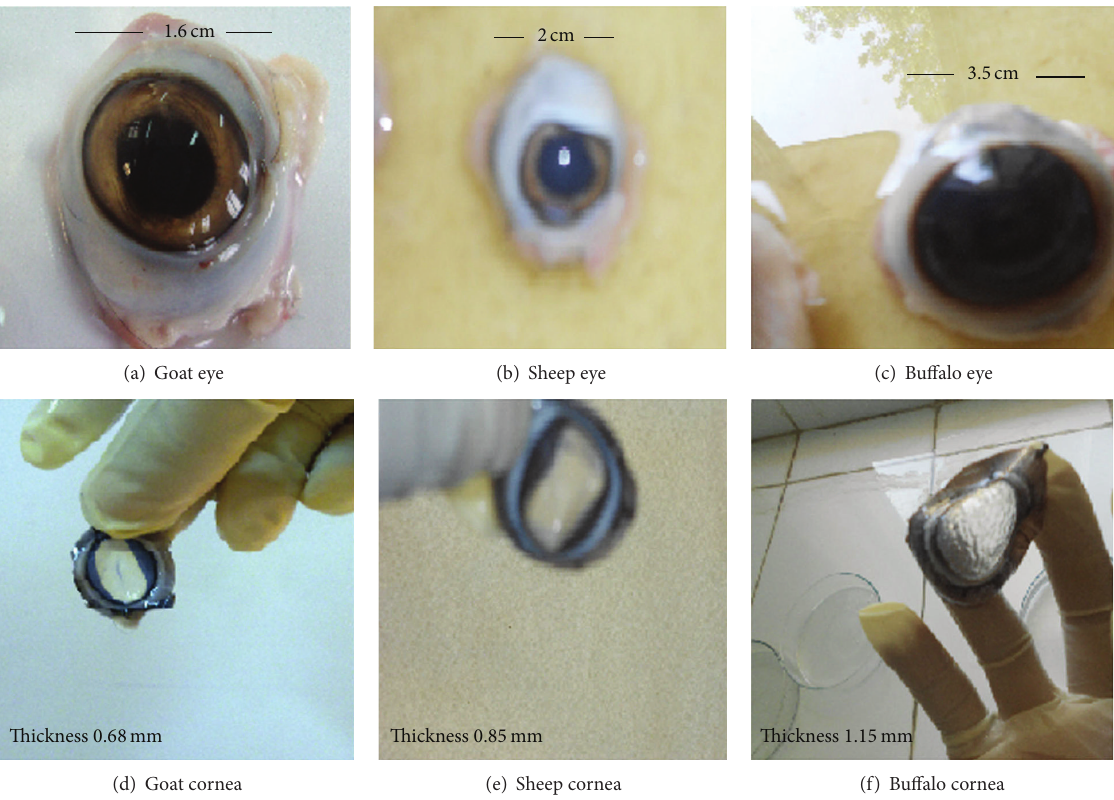
Figure 1: Optical observation: (a) goat eye, (b) sheep eye, (c) buffalo eye, (d) goat cornea, (e) sheep cornea, and (f) buffalo